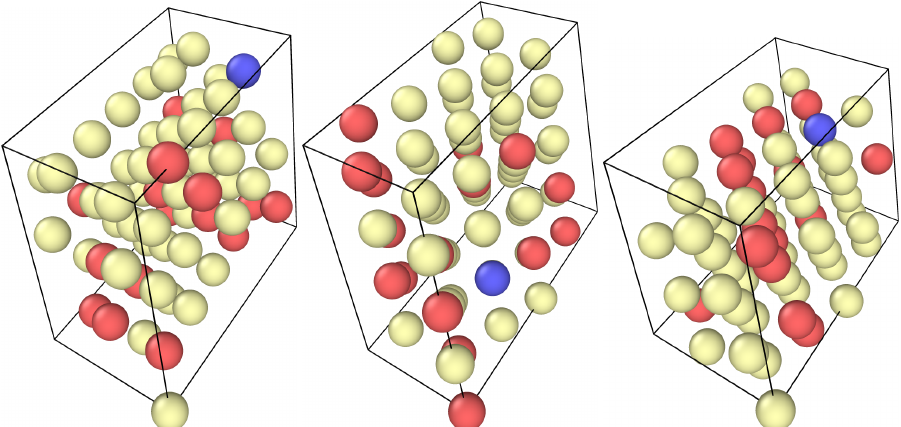
Figure 1. The 3 special quasirandom structures with composition Ni 47 Co 16 X; Ni atoms in yellow, Co atoms in red, alloying element in